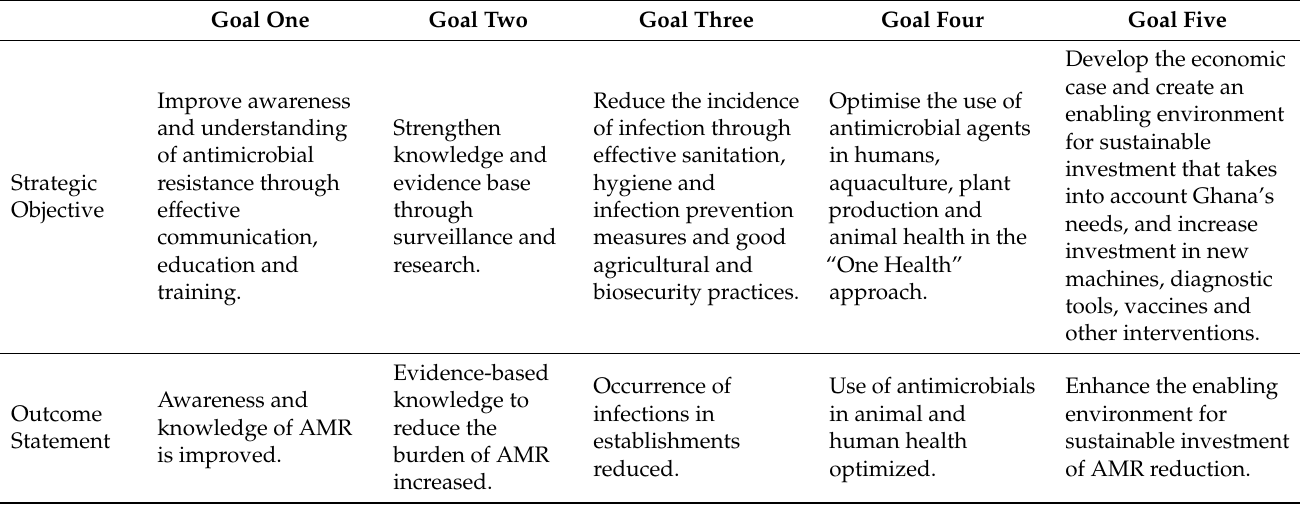
Table 1. AMR Monitoring and Evaluation Framework. Source: Own design, based on Ghana’s National Action Plan, p.